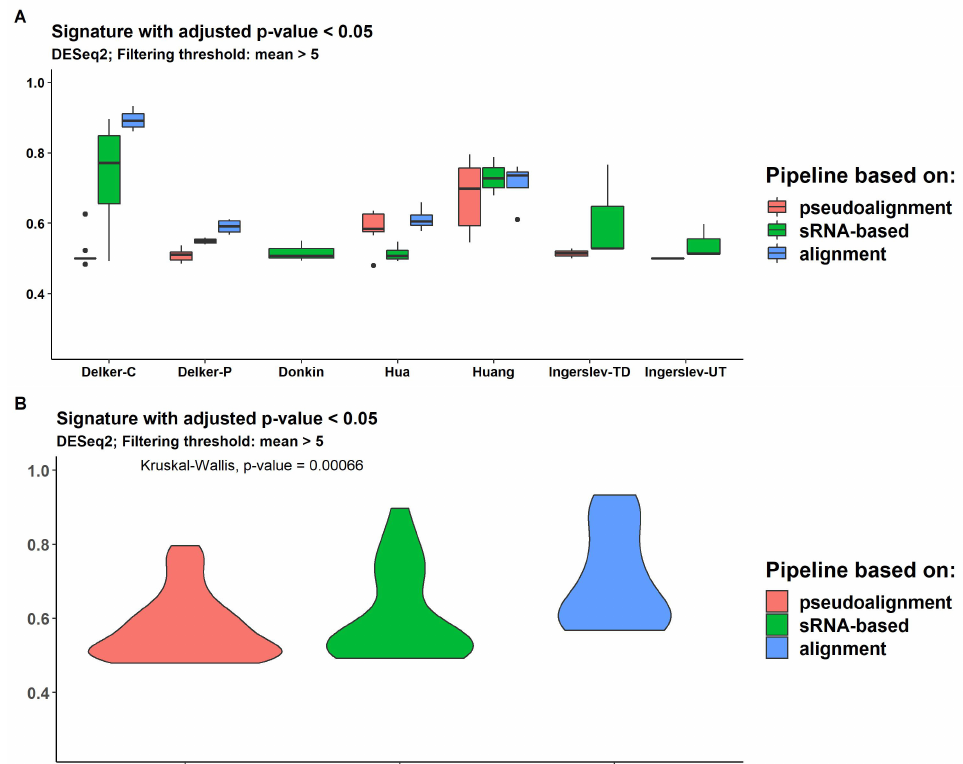
Figure 7. Distribution of H-scores across pseudoalignment-based pipelines (kallisto and salmon), sRNA-based pipelines (SPORTS and sRNAnalyzer) and alignment-based pipelines (bowtie, hisat, STAR and rsem) for every dataset [59,60,62–64] ( A ) and for all data ( B